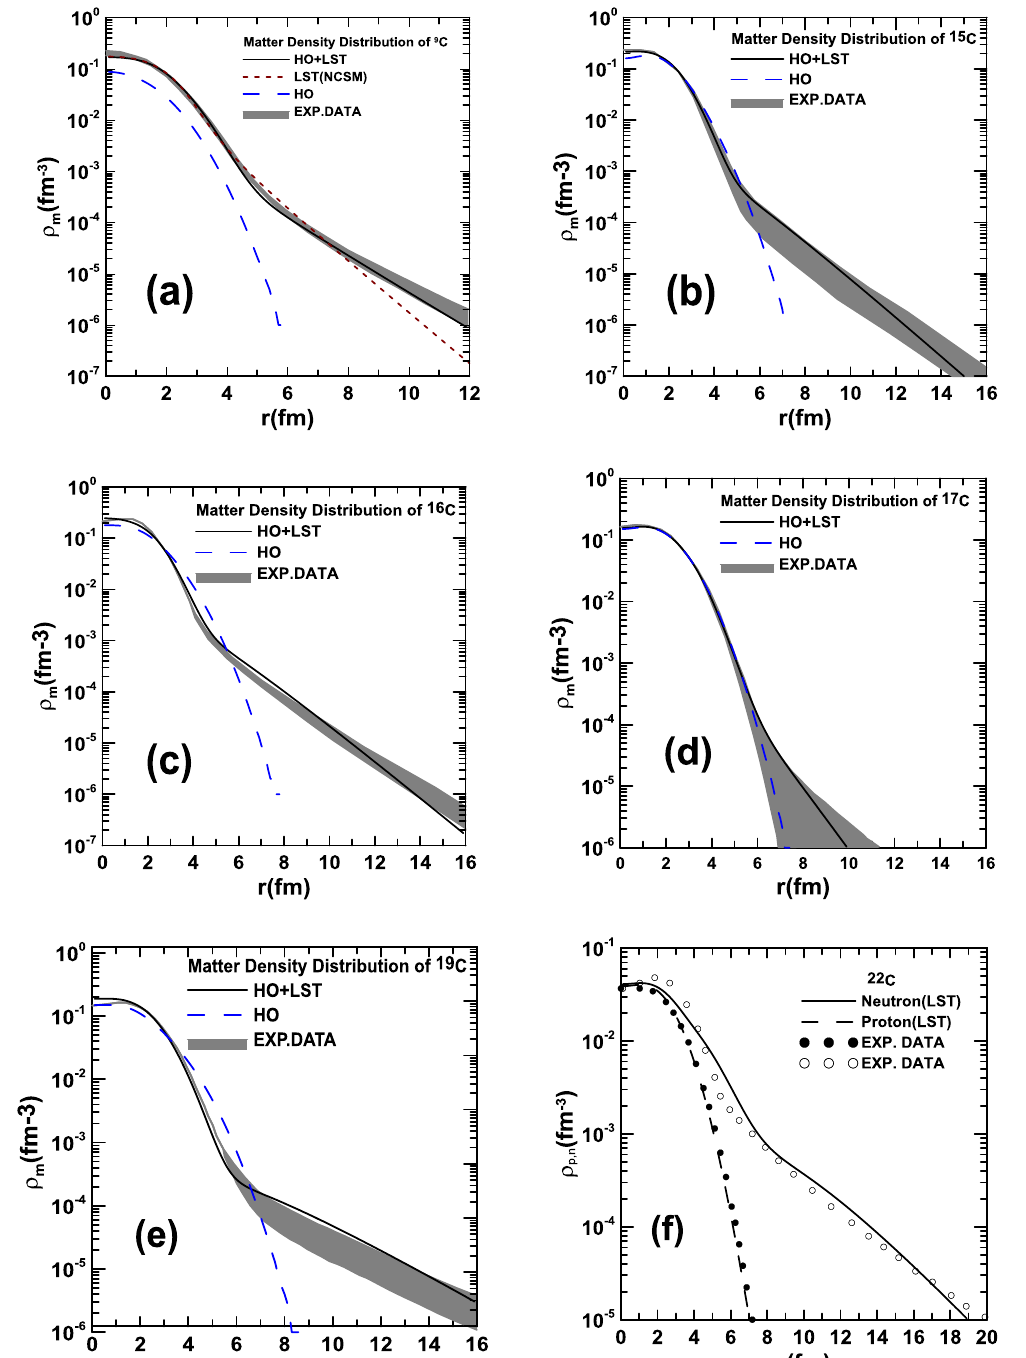
Fig. 1: The calculated MDDs for exotic Carbon isotopes 9 C(a) [30], 15 C(b), 16 C(c), 17 C (d) and 19 C(e) [11], represented by solid and dashed curves, respectively. The shaded areas are experimental data. 22 C(f), represent the neutron and proton density distribution and compared with experimental data represent by filled and empty [29]